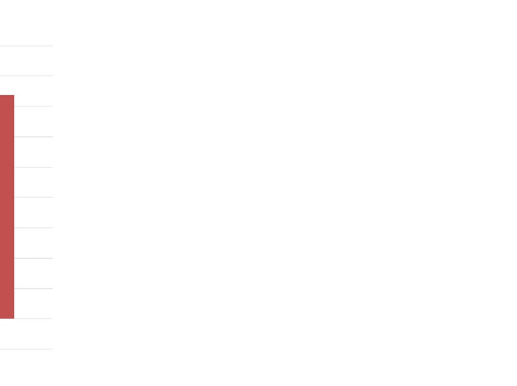
Figure 1. Cognitive changes in the Wisconsin Card Sorting Test (WCST) for rs10466907 genotypes. Note: Z scores for the different neuropsychological testes were calculated using respective mean and standard deviation (SD). WCST1: total scores completed; WCST2: total error; WCST 3: random error. Carriers with rs10466907 GT genotype did not significantly improve their cognitive functioning compared with those carriers with TT genotypes after six weeks of treatment for bipolar